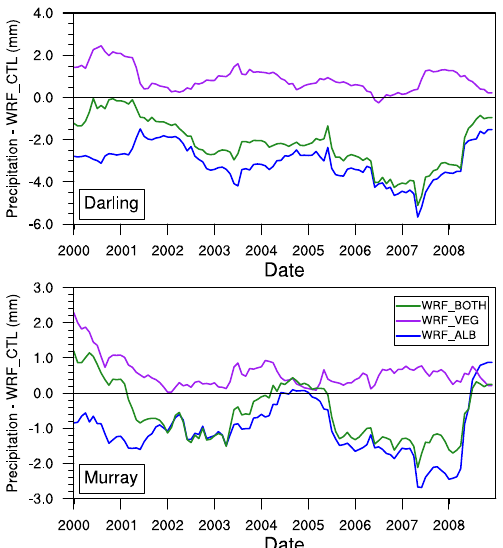
Figure 5. The 12-month running average precipitation (mmmonth − 1 ) for each model simulation and observations, averaged over each river basin.